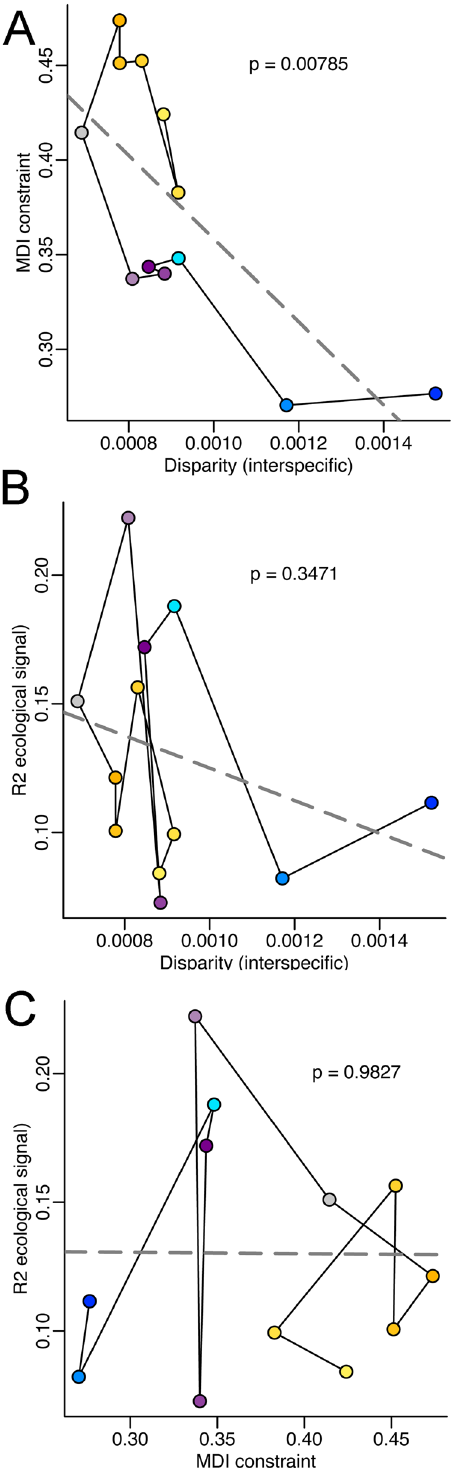
Fig. 8 Relationships between ecomorphological adaptation, evolutionary constraint (MDI) and among-species disparity selecting vertebrae by position. A Bivariate plot of MDI values against among-species disparity. B Bivariate plot between the strength of ecomorphological signal ( R 2 from the best Procrustes ANOVA analyses) and interspeci fi c disparity. C Bivariate plot between the strength of ecomorphological signal ( R 2 from the best Procrustes ANOVA analyses) and evolutionary constraint